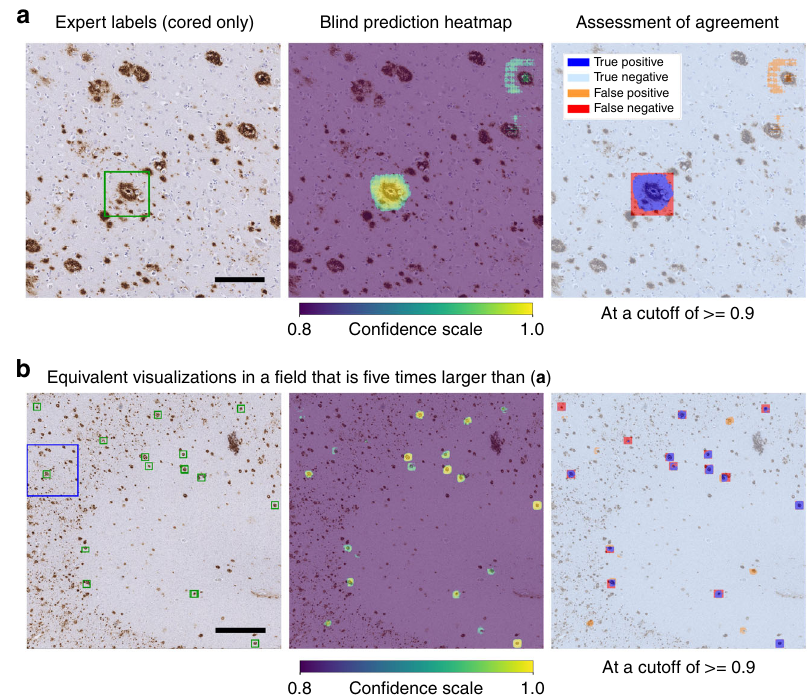
Fig. 6 Visualization of a representative example from the cored-plaque classi fi cation tests plotted in Fig. 4. a CNN model prediction con fi dence maps (middle panel, as in Fig. 5c) overlaid onto the original slide tile. Bounding boxes mark cored-plaque expert annotations (left panel, green box). The combined map (right panel) assesses agreement between the model ’ s predictions and the expert labels, where pixels are colored by a semi-transparent overlay as true positive (blue), false positive (orange), true negative (cyan), and false negative (red) areas. Scale bar = 150 μ m. b Prediction-versus- annotation agreement map generated as in a , but with a larger fi eld for greater tissue and plaque clustering context. Scale bar = 750 μ m. Con fi dence scales for middle panel are bottom-capped to aid visualization, such that only con fi dence scores ≥ 0.8 are plotted, with yellow being the most con fi dent